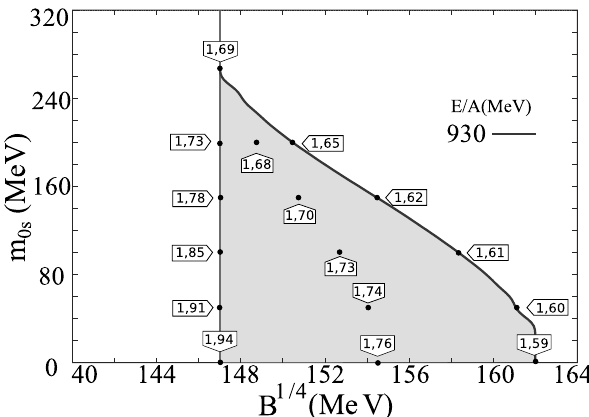
Figure 20. Stability window shown in the shaded area. The flags indicate the maximum stellar masses obtained with various B and strange quark mass values. Figure taken from